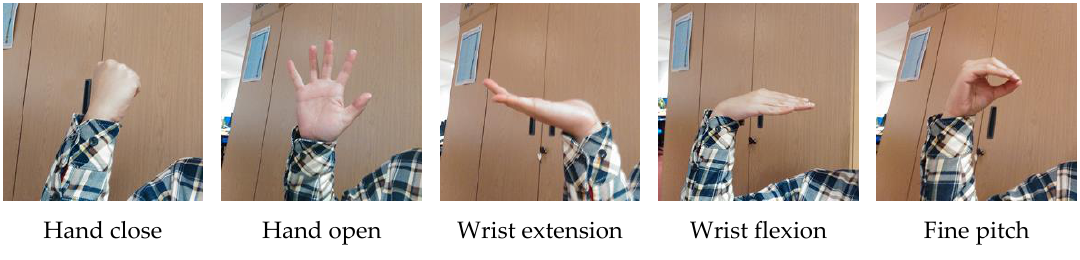
Figure 15. Five hand gestures for recognition.